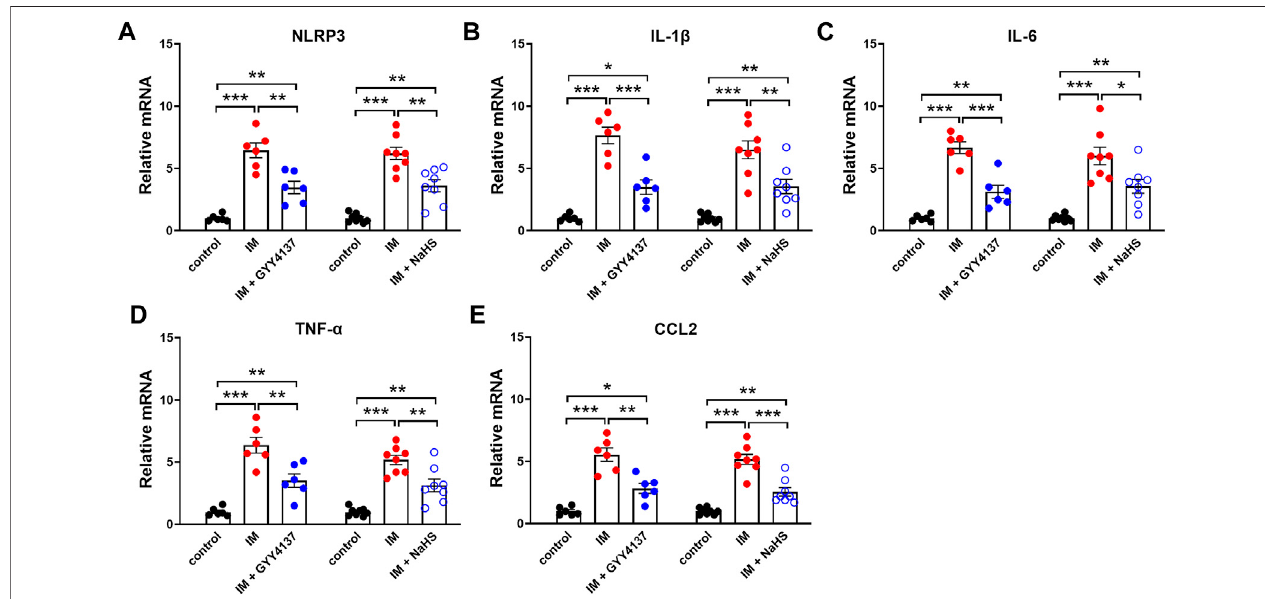
FIGURE6| H2SdonorsinhibittheIM-inducedmNRAexpressionsofpro-in fl ammatorybiomarkersinskeletalmuscles.MiceweresubjectedtoIMandtreatedwith GYY4137 (50 μ g/kg/d, ip, n = 6), or NaHS (1.12 mg/kg, twice a day, ip, n = 8) for 2 weeks. Thecontrol and IM groups received identical doses ofsaline for2 weeks. a-e showed mRNA expressions of pro-in fl ammatory biomarkers including NLRP3 (A) , IL-1 β (B) , IL-6 (C) , TNF- α (D) , and CCL2 (E) in TA muscles. Data represent means ± SEM. * p < 0.05, ** p < 0.01, *** p < 0.001.